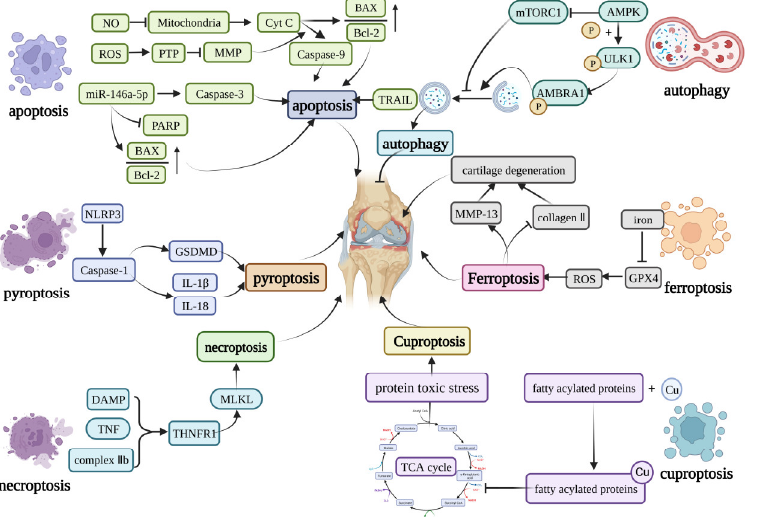
Figure 1. Core molecular mechanisms of programmed cell death in OA. The apoptosis can be induced by caspase-9, caspase-3, TRAIL, and the increase in the BAX/Bcl-2. Pyroptosis is mainly induced by the NLRP3 inflammasome. The NLRP3 inflammasome can activate GSDMD or induce the production of IL-1β and IL-18 to induce pyroptosis. The DAMP, TNF, and complex IIb can induce necroptosis by activating the MLKL. Curprotosis can be induced by the accumulation of copper ions, which can affect the TCA cycle to produce more protein-toxic stress. The over-accumulation of iron can induce ferroptosis by overproduction of ROS, and ferroptosis can lead to the expression of MMP-13 and inhibit the expression of collagen II. The AMPK can inhibit the activation of mTORC1, which can inhibit autophagy or phosphorylation of the ULK1, creating a phosphorylated AMBRA1 to induce autophagy. This figure has been created at https://app.biorender.com (accessed on 21 January 2023).